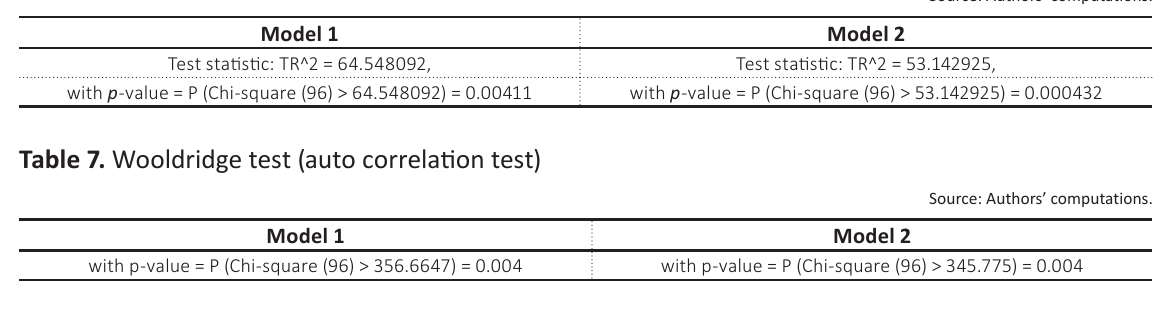
Source: Authors’ computations.